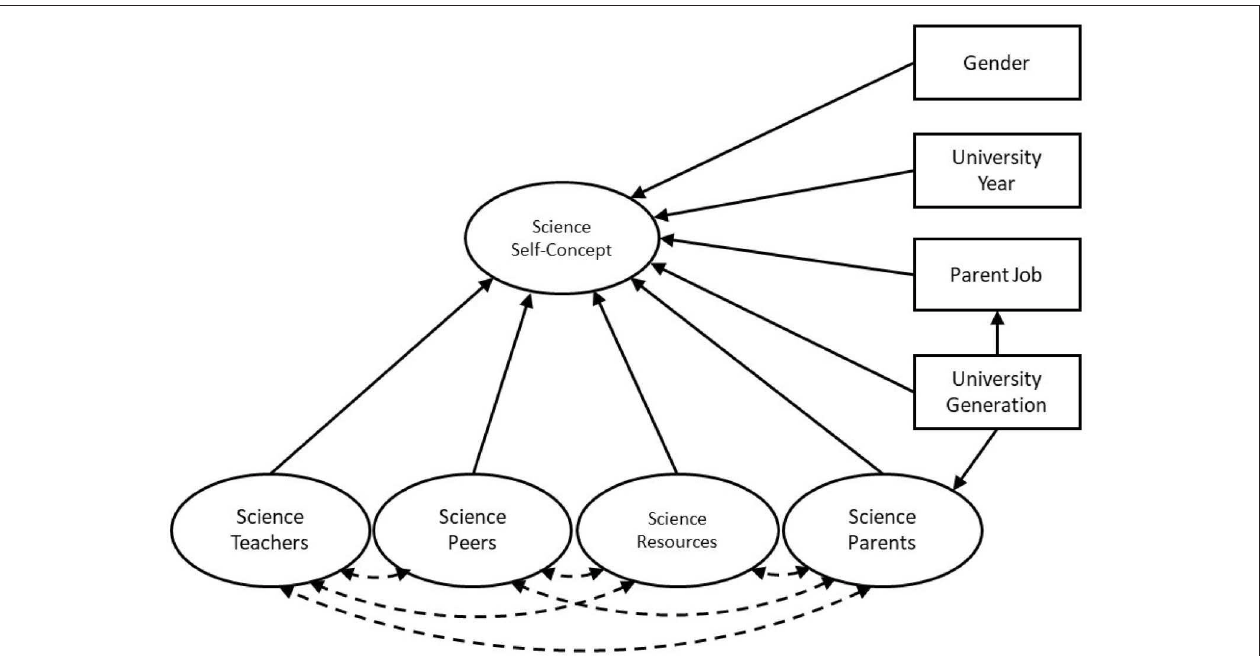
FIGURE 1 | Conceptual Model. Latent variables are represented by oval boxes, observed variables are represented by rectangular boxes. Regressions are represented by one-sided arrows, while correlations are represented by double headed arrows and dashed